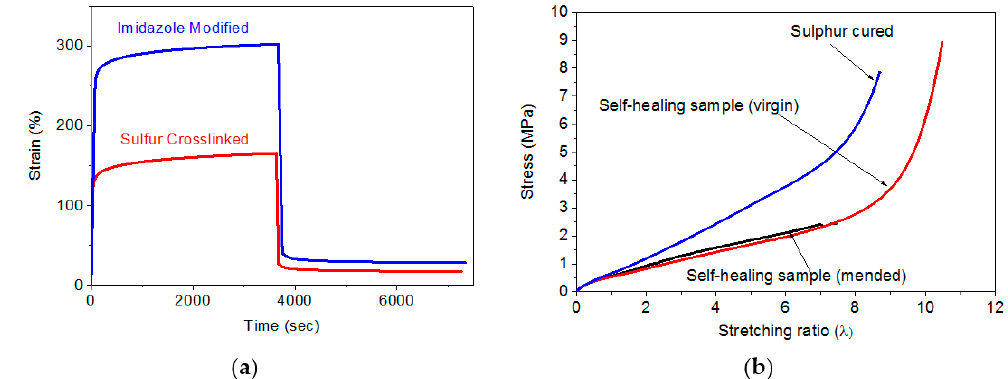
Figure 3. ( a ) Stretching experiment of the modified BIIR and the mended sample. The mended sample was previously cut half of the width and allowed to heal for 1 h; ( b ) Creeping experiment of the sulphur vulcanized and modified BIIR rubbers.